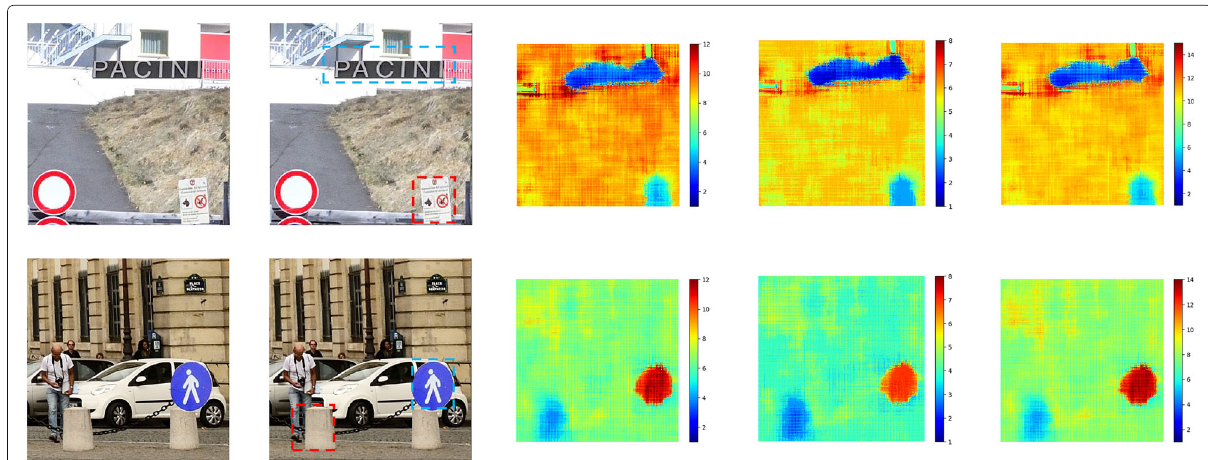
Fig. 12 Examples of tampered (double JPEG) images and map of the estimated k -th Q 1 coefficient, for some values of k . For each example, we report, from left to right: the tampered image, the ground-truth tampering map, the estimated map for the DCT coefficient no 1, 6, and 14, that is QM ( :,:,1 ) , QM ( :,:,6 ) and QM ( :,:,14